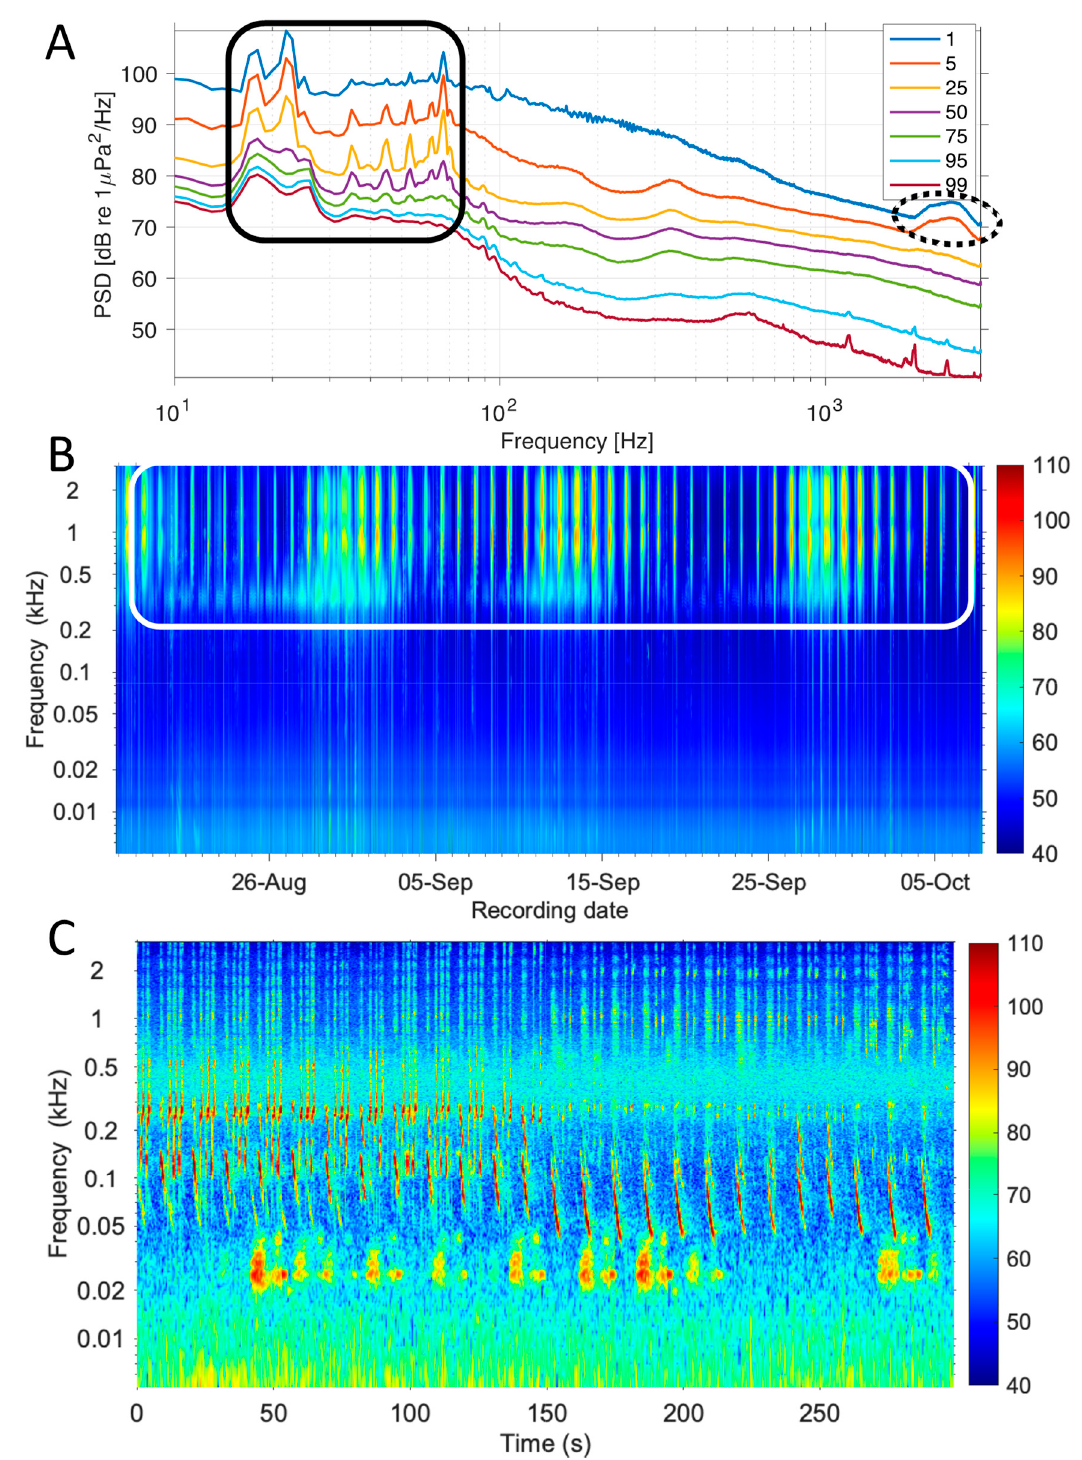
Figure 11. ( A ) Power spectral density percentiles of the winter soundscape at site 15 dominated by pygmy blue whales (within black box). The characteristic spectral shape of a fish chorus is seen at 2–3 kHz in the 1st and 5th percentiles (dotted); ( B ) LTSA of the pristine soundscape at site 4 exhibiting multiple fish choruses at night (within white box), whose intensities vary with the phase of the moon; ( C ) Spectrogram of the soundscape at site 1 showing at least two simultaneous whale species (Omura’s whales at 20–50 Hz and one other at 50–3000 Hz, uncertain) and a fish chorus at 300–500 Hz.